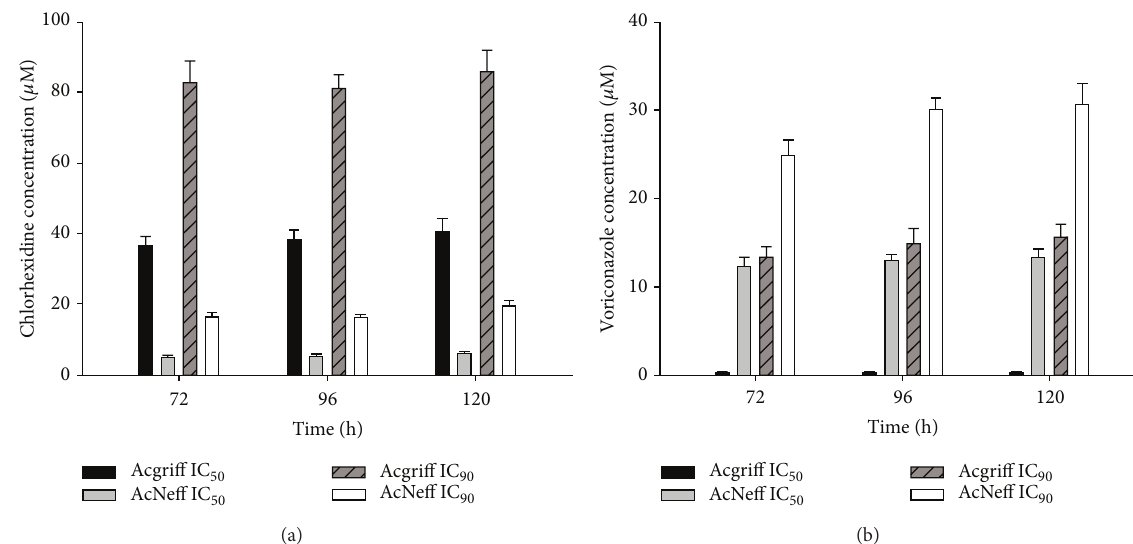
Figure 5: In vitro activity of chlorhexidine (a) and voriconazole (b) against the Acanthamoeba griffini strain. Acanthamoeba castellanii Neff ATCC 30010 was used as a control strain. Activities and concentrations (IC 50 and IC 90 ) of the tested compounds are shown at 72, 96, and 120